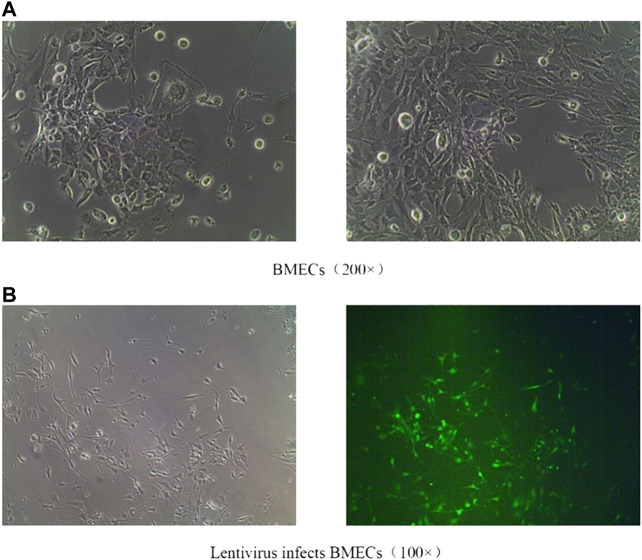

(A): Normal BMECs; (B): Effective transfection of BMECs with lentiviruses.